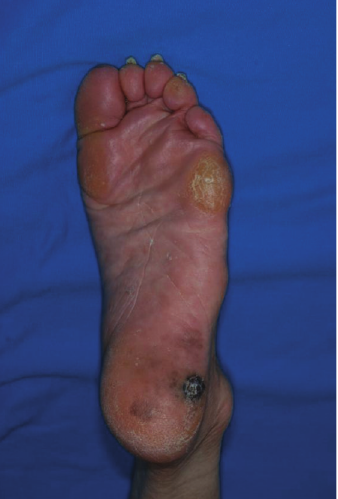
Figure 1: The findings of primary skin tumor when first diagnosed. The lesion was 55×40 mm in size with a 15mm-diameter nonulcer- ated nodule in the center.